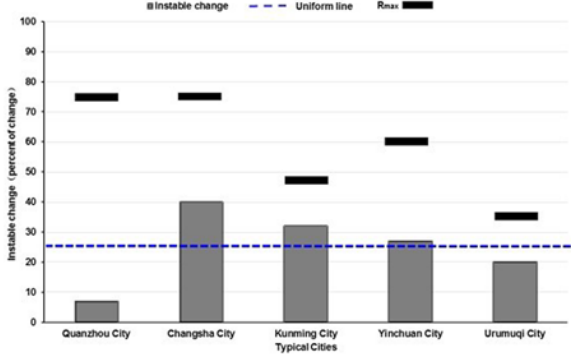
Figure. 6 Comparison of the land use change with instability in typical cities.